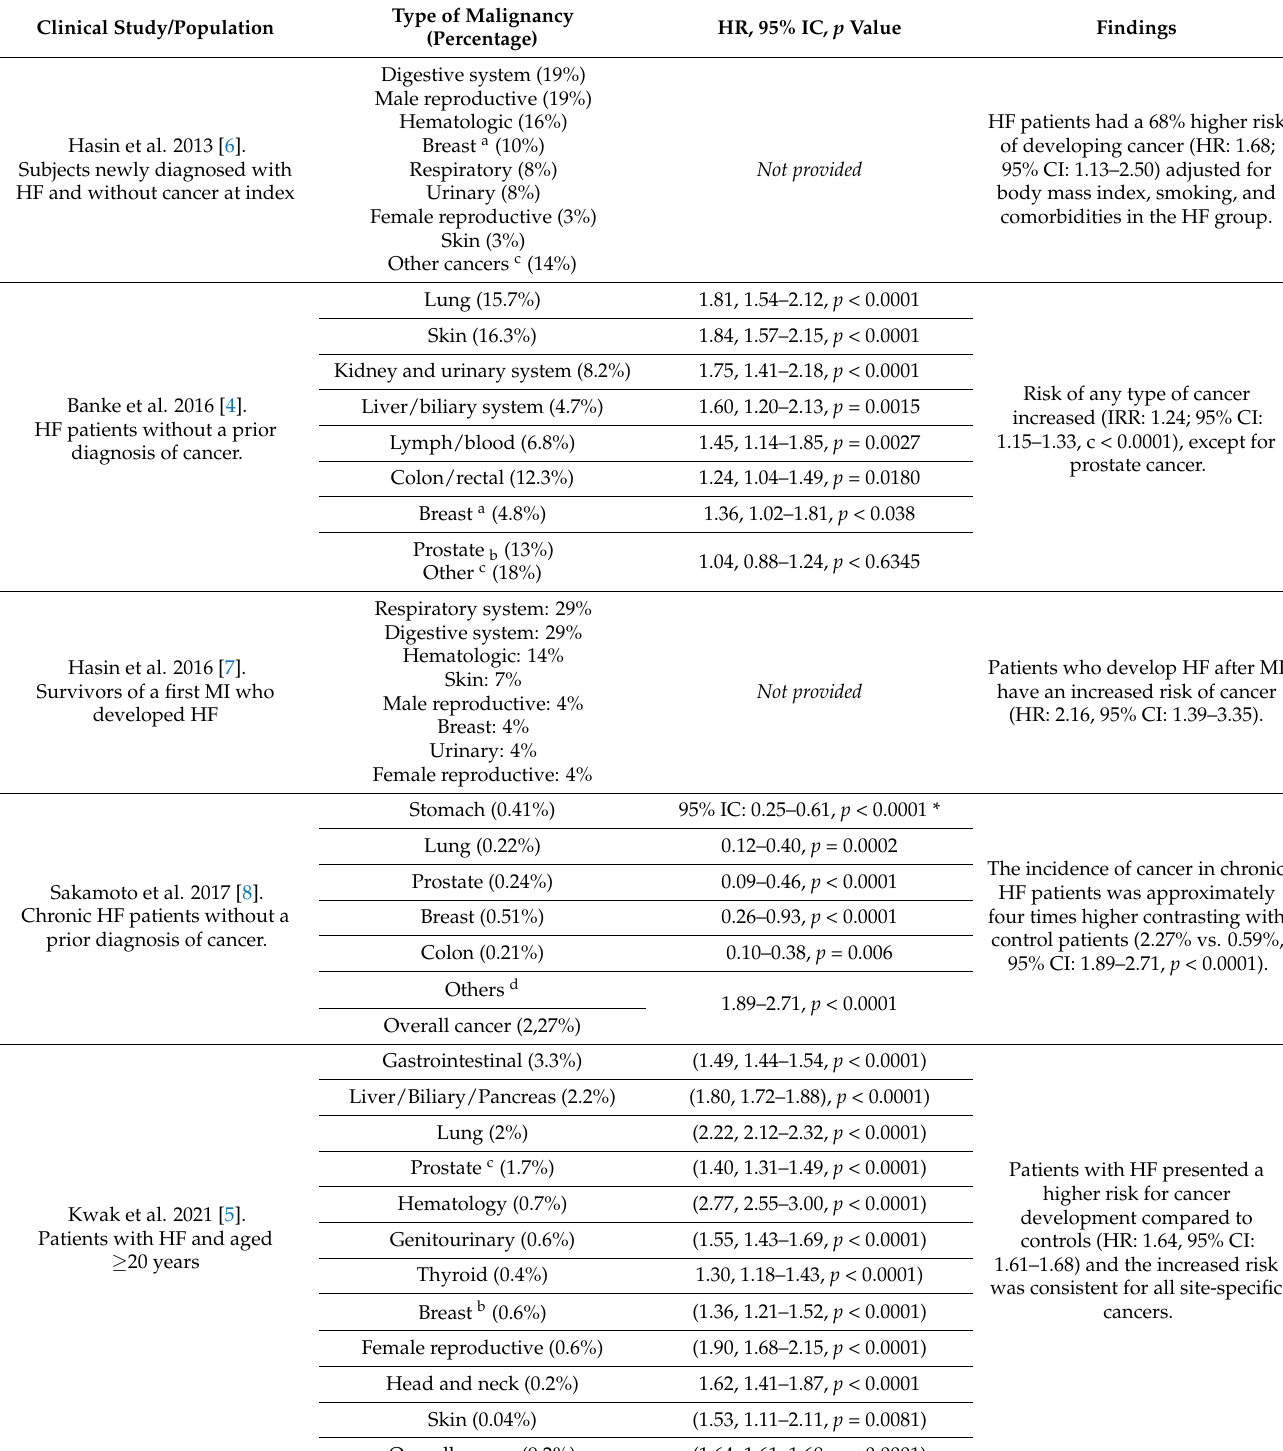
Table 1. Findings of observational studies evaluating incidence of cancer in patients with